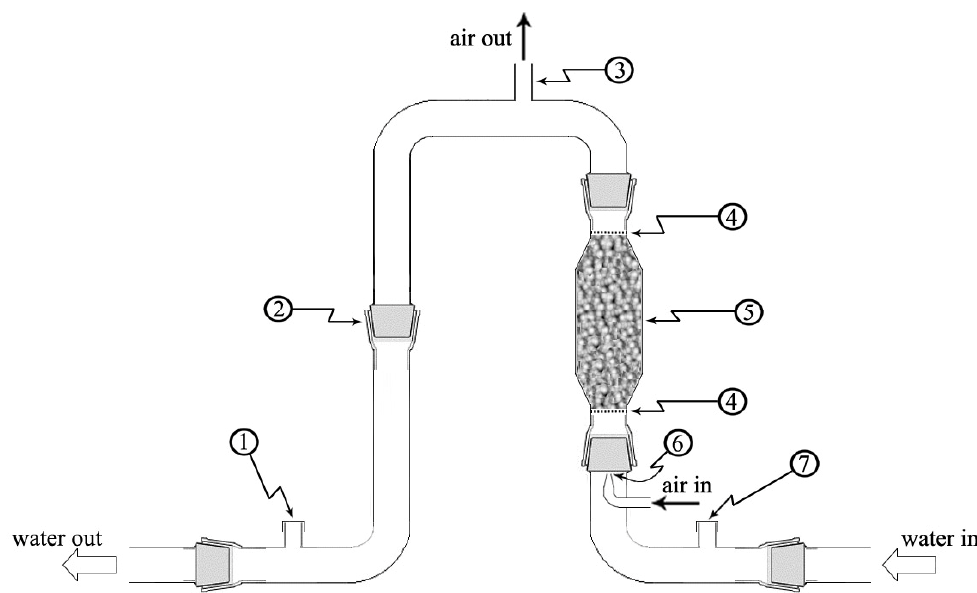
Figure 1. Schematic representation of the bench-scale module for the decontamination of units of sediment (mini-MODUS). Legend: (1) “water out” sampling point, (2) ground glass joint (conically tapered joint), (3) degassing chamber chimney, (4) grids, (5) air-lift reactor (oxygenation / aeration reactor) filled with Rashig rings, (6) sparger, and (7) “water in” sampling point.